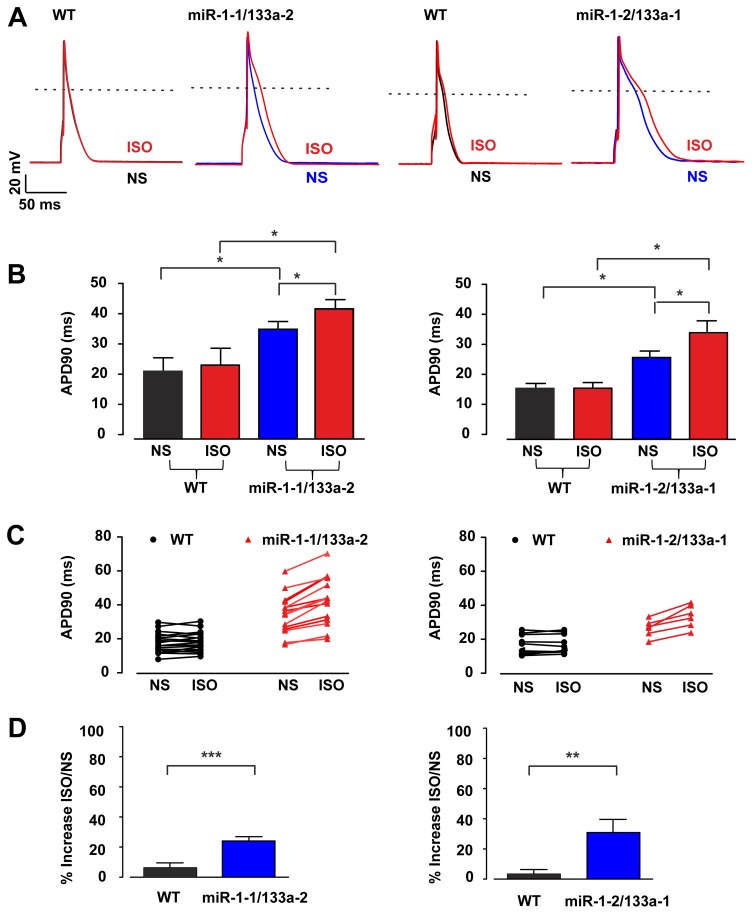
ß-adrenergic signaling prolongs APD90 in miR KO ventricular cardiomyocytes.Representative APs of control (black traces) and KO cells without (blue traces) and in presence of Isoproterenol (ISO; 1 µM, red traces) (A). Statistics of APD90 in miR WT and KO cells without and with ISO (B). Point graphs of APD90 of individual cells prior and after Isoproterenol application underscores the different response of control and miRNA KO cells (C). Percentage of increase of APD90 in miR control and KO cells (D).